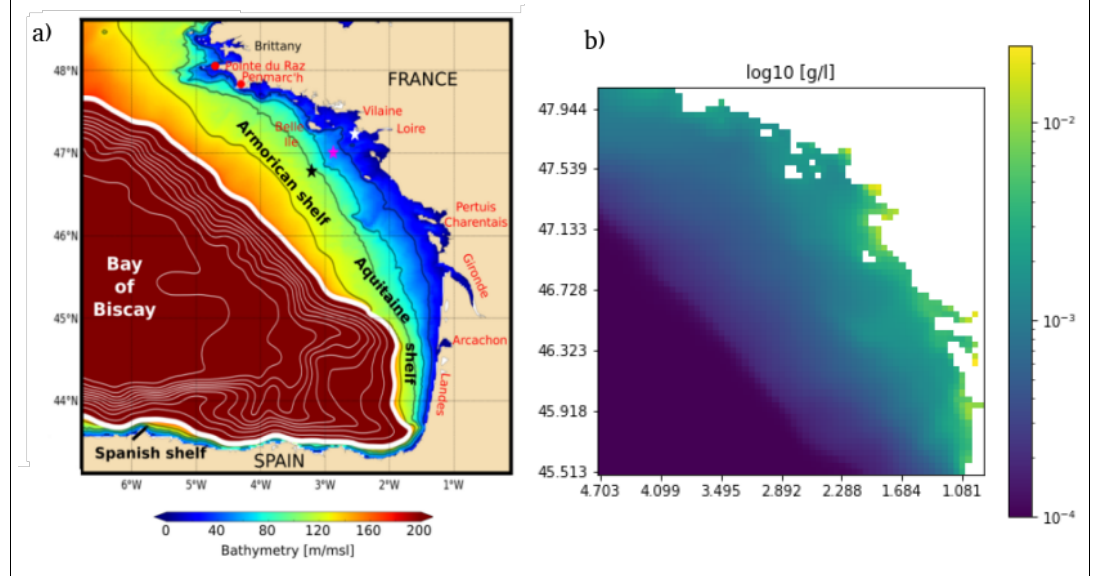
Figure 1. ( a ) Bathymetry of the Bay of Biscay. Black lines represent isobaths 40, 70, 100, and 130 m. The thick white line (corresponding to the 180 m isobath) approximately delimits the shelf edge. ( b ) Mean spatial distribution of the log10 SSSC (g/L) from the MARS-MUSTANG hydrosedimentary